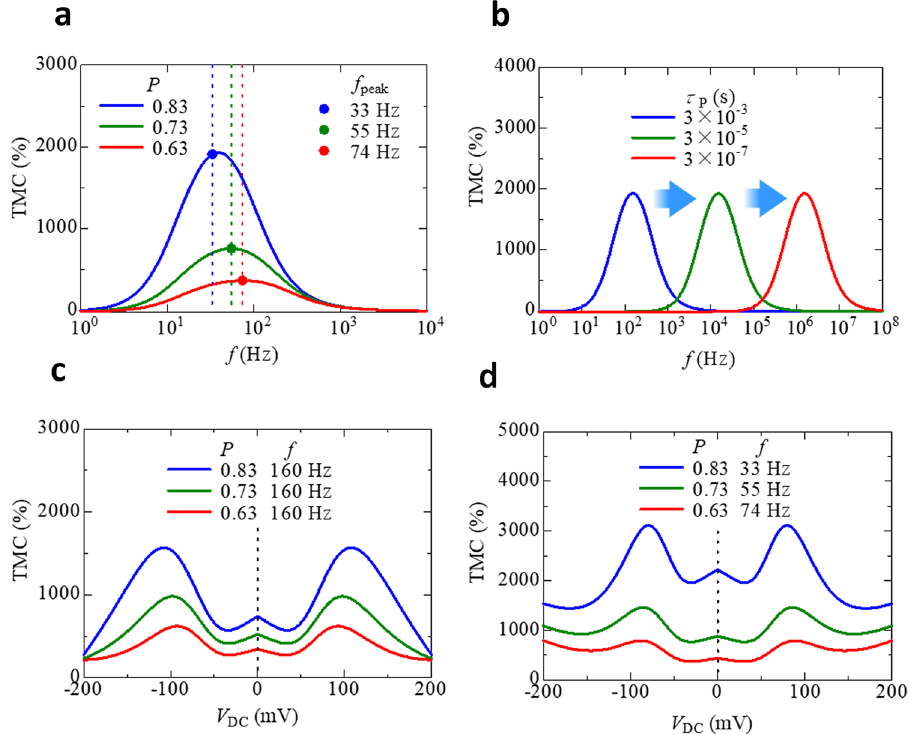
Figure 5. Prediction of an extremely large voltage-induced TMC. ( a ) Calculated frequency dependence of the TMC under no bias voltage with varying spin polarization P . ( b ) Calculated frequency dependence of the TMC with varying τ P . The peak position of the TMC is shifted to a high frequency region for a short τ P . Calculated voltage-induced TMC with varying ( c ) P at 160 Hz and ( d ) at f peak . Note the maximum TMC is about